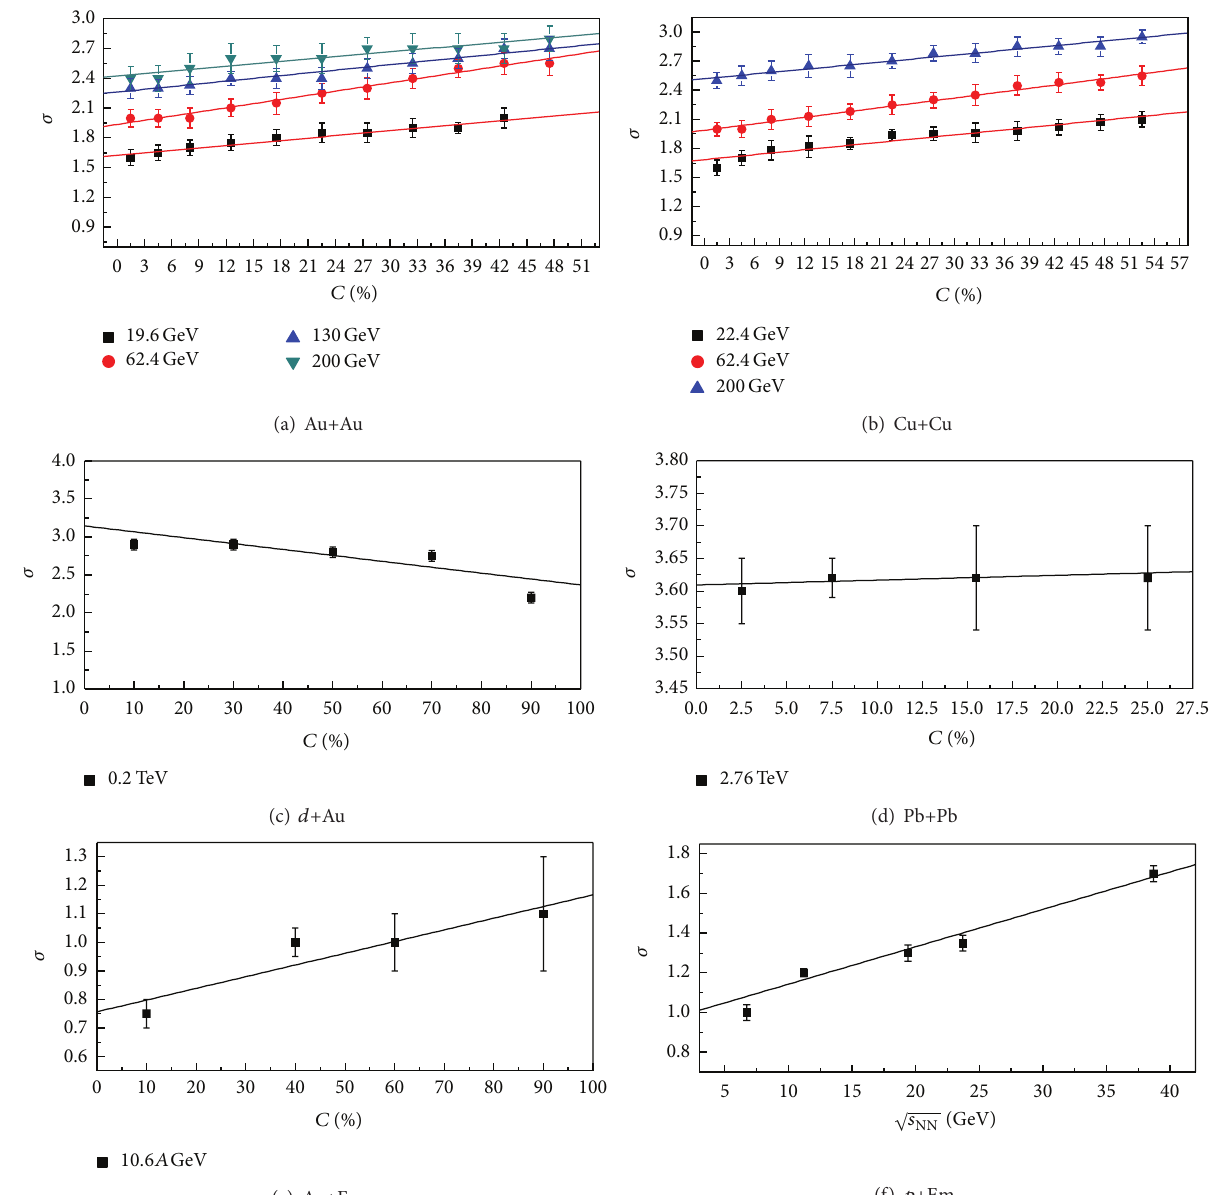
Figure 13: Dependencies of 𝜎 in central sources in Au-Au, Cu-Cu, d -Au, Pb-Pb, Au-Em, and 𝑝 -Em collisions on C or √𝑠 NN . The symbols are quoted in Tables 1–6, and the lines are our fitted